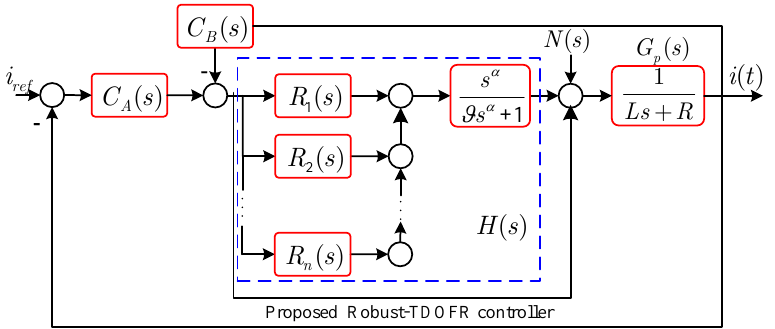
− TDOF cascaded resonant Figure 2. Control diagram of Robust−TDOF cascaded resonant controller. Figure 2. Control diagram of Robust